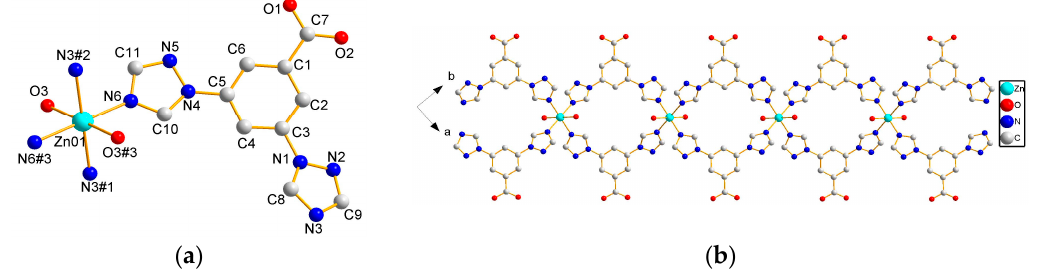
Figure 1. ( a ) Coordination environment of Zn(II) ion in 1 ; ( b ) The 1D chain of 1 .